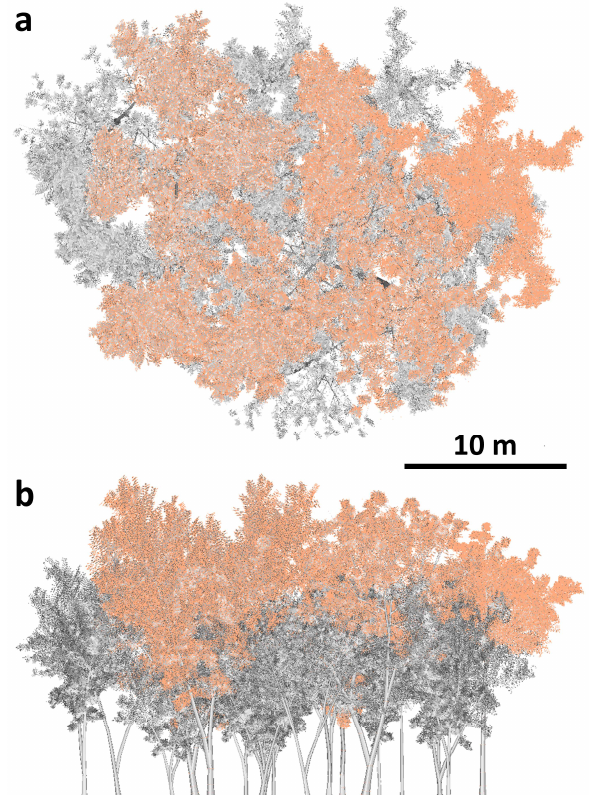
Figure 2: 3D triangle mesh tree models constituting the virtual forest plot scanned in the simulation. (a) Bird’s eye view, (b) side view. Orange: 5 dominant trees, grey: 15 understory